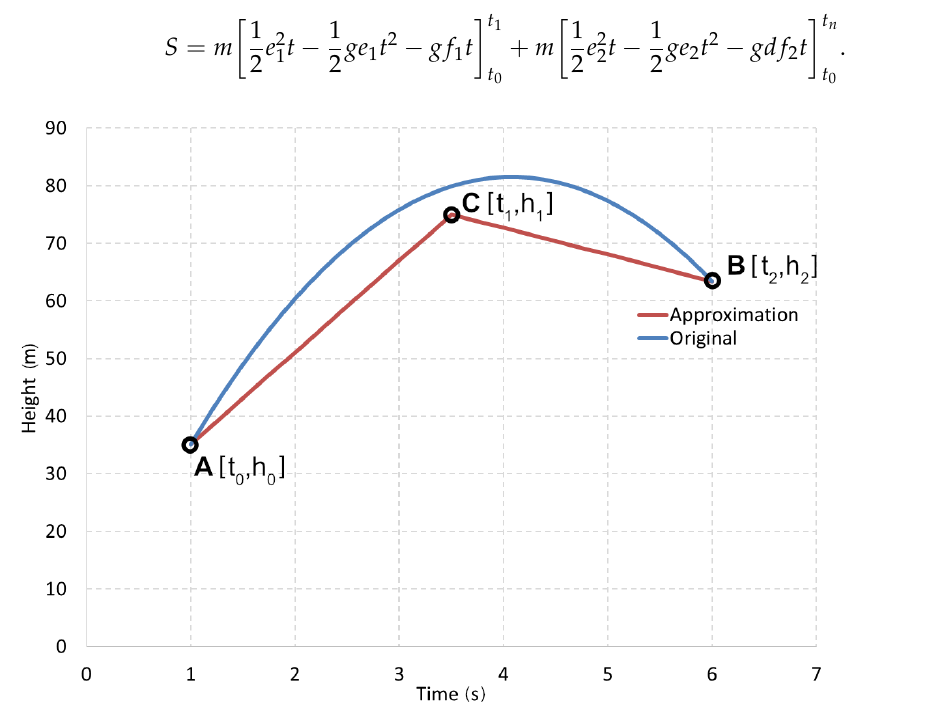
Figure 1. General principles of the Minimum Energy Effect